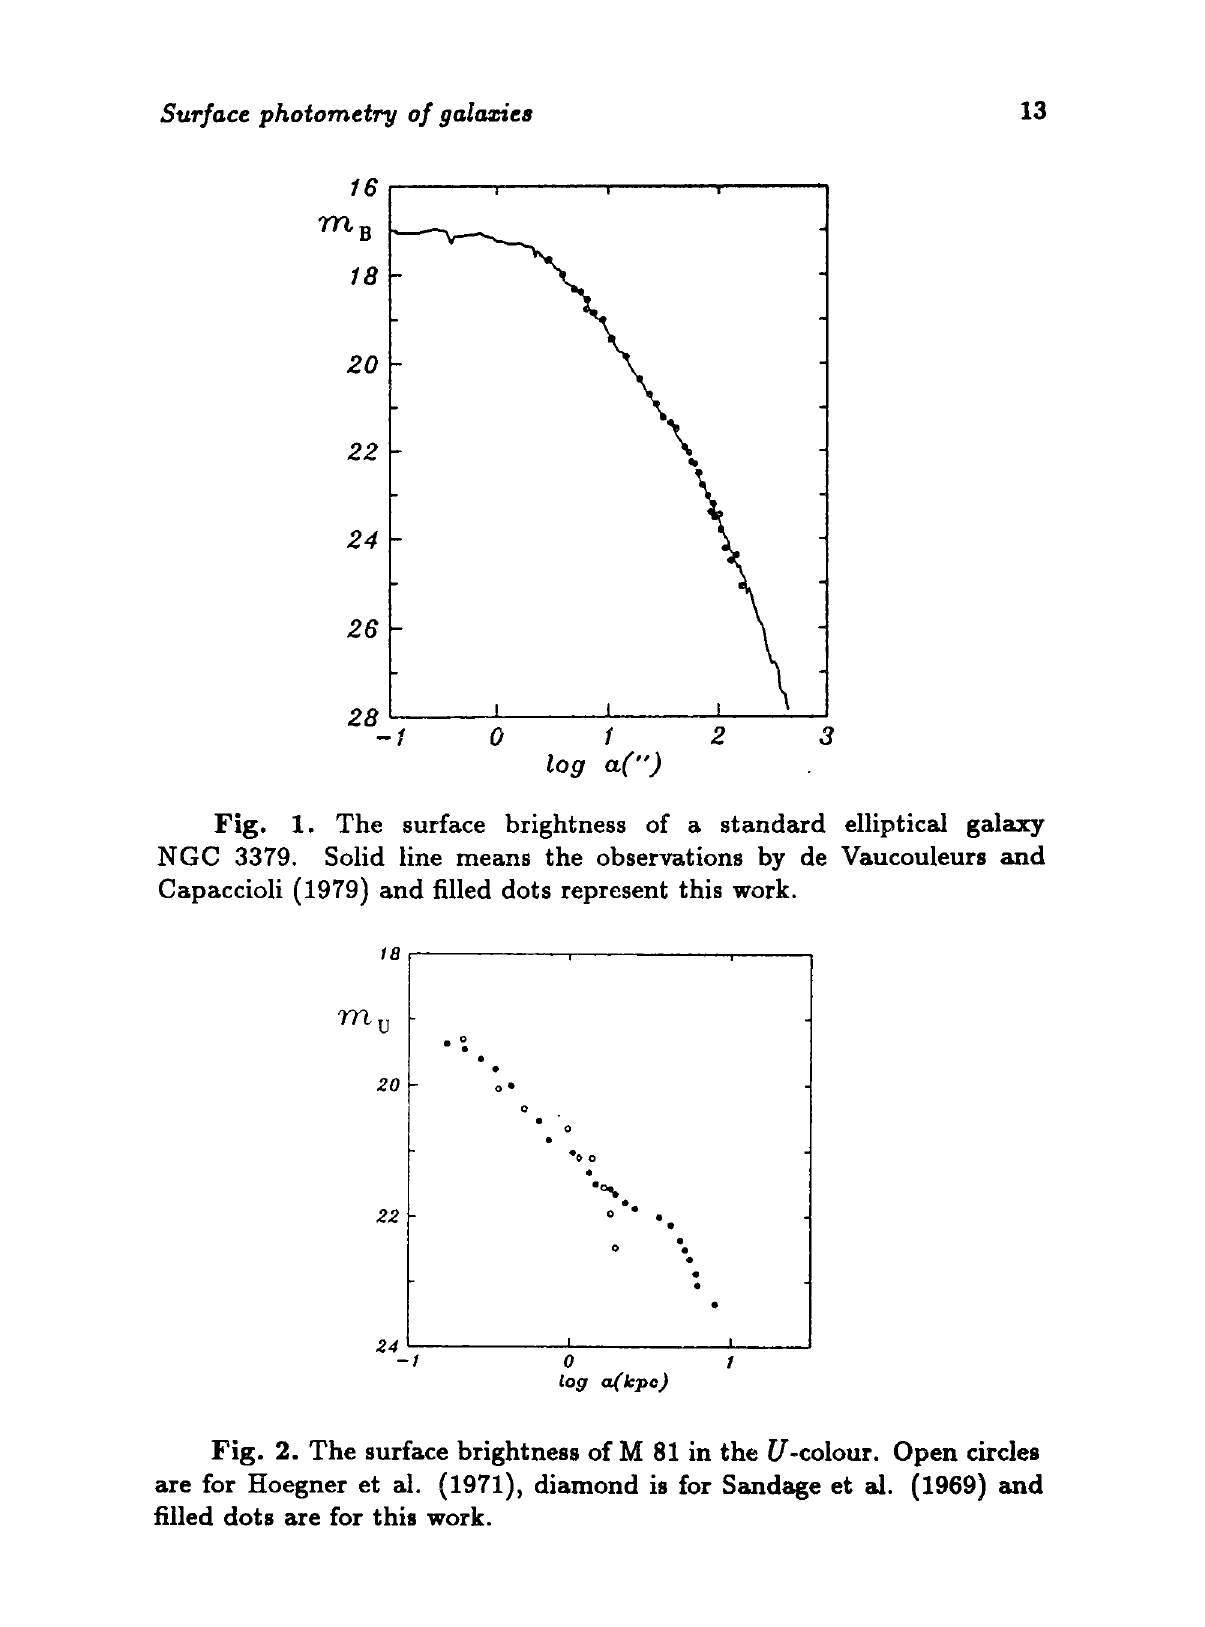
Fig. 2. The surface brightness of M 81 in the [/-colour. Open circles are for Hoegner et al. (1971), diamond is for Sandage et al. (1969) and filled dots are for this